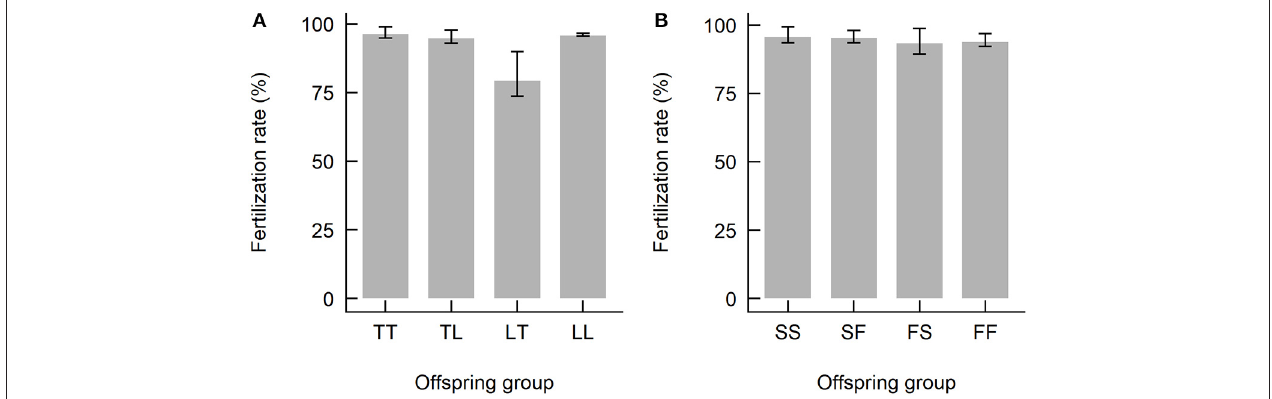
FIGURE 3 | Fertilization rates of the offspring groups from (A) the Acropora tenuis (T) × Acropora loripes (L) cross, and (B) the Acropora sarmentosa (S) × Acropora florida (F) cross. The abbreviation of the offspring groups is that the first letter represents the origin of the eggs and the second letter the origin of sperm, where TL, LT, SF, FS are hybrids and TT, LL, SS, FF are purebreds.Values are mean and error bars represent 95% CI calculated using the angular transformed data back-transformed into percentages.